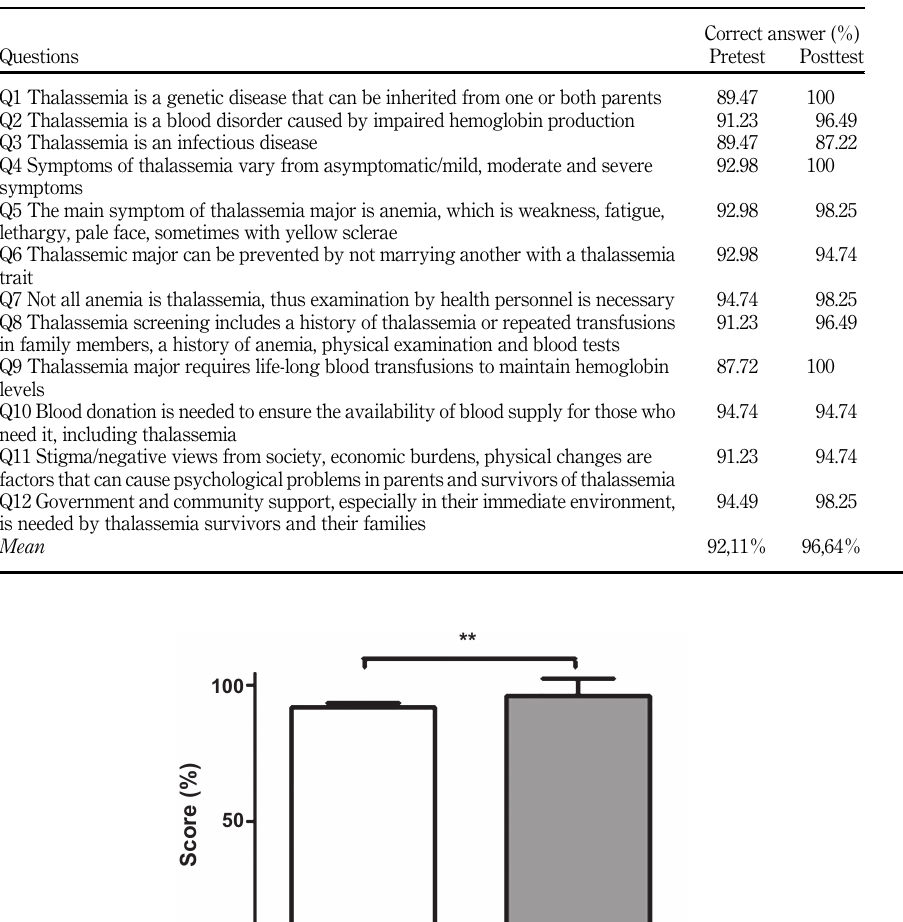
Figure 1. Comparison between the pretest and posttest